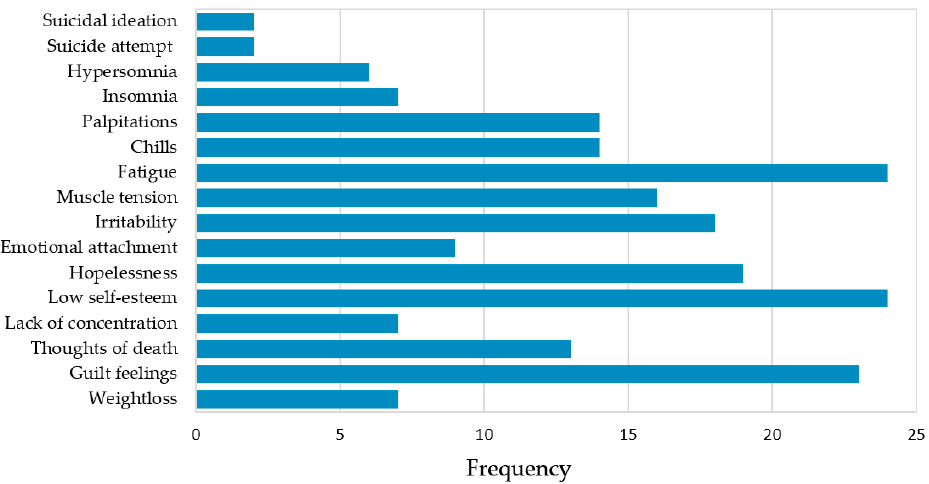
Figure 3. Frequency of symptoms associated with major depressive disorder and generalized anxiety disorder, according to the DSM-5. Figure 3 shows the most frequent DSM-5 criteria for major depressive disorder collected in the psychological history of the participants (n = 26). Low self- esteem, lack of concentration, and fatigue had a frequency of 92.3%.